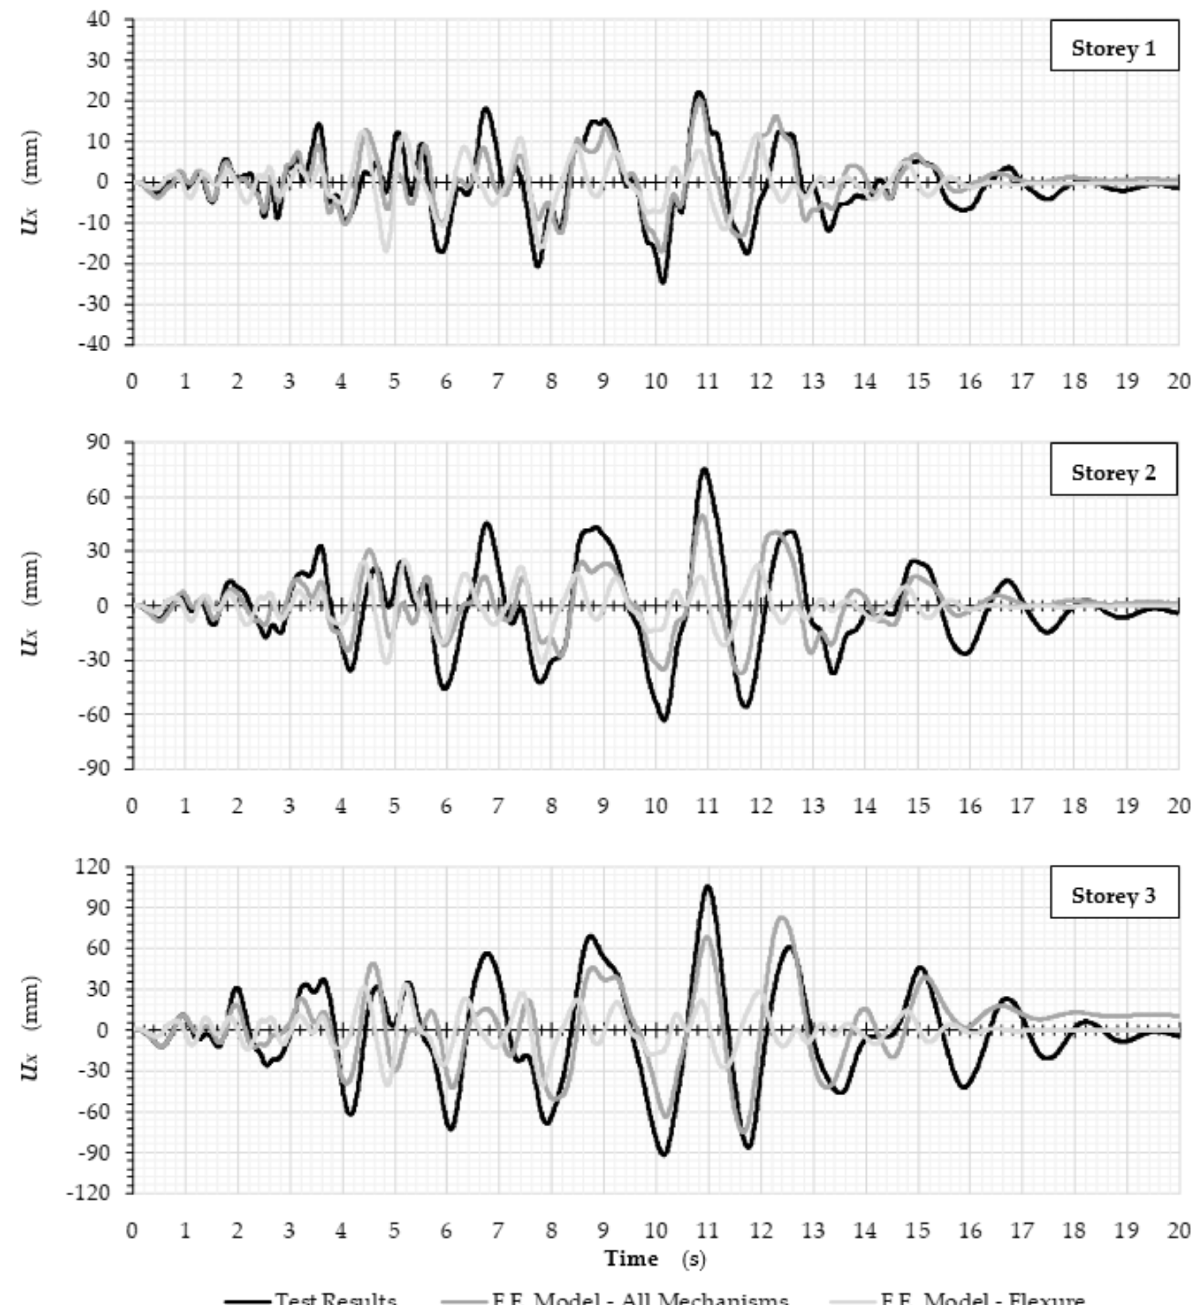
Figure 12. Comparison of the horizontal displacements in the X -plan direction measured at the SPEAR building during the s12 earthquake case and the corresponding response estimated from a dynamic analysis using two different FE building